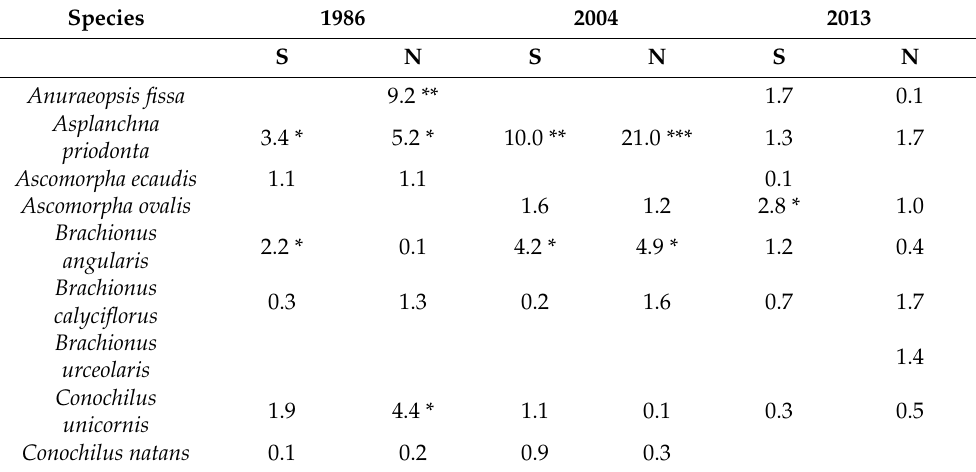
Table 1. Planktonic rotifer species (percentage of abundance) recorded at the sites in Lake Kortowskie (S–the site in the southern basin of the lake, where the pipeline is located, N–the site in the northern basin of the lake). The level of species dominance (D) is indicated as follows: *** eudominant; ** dominant; *